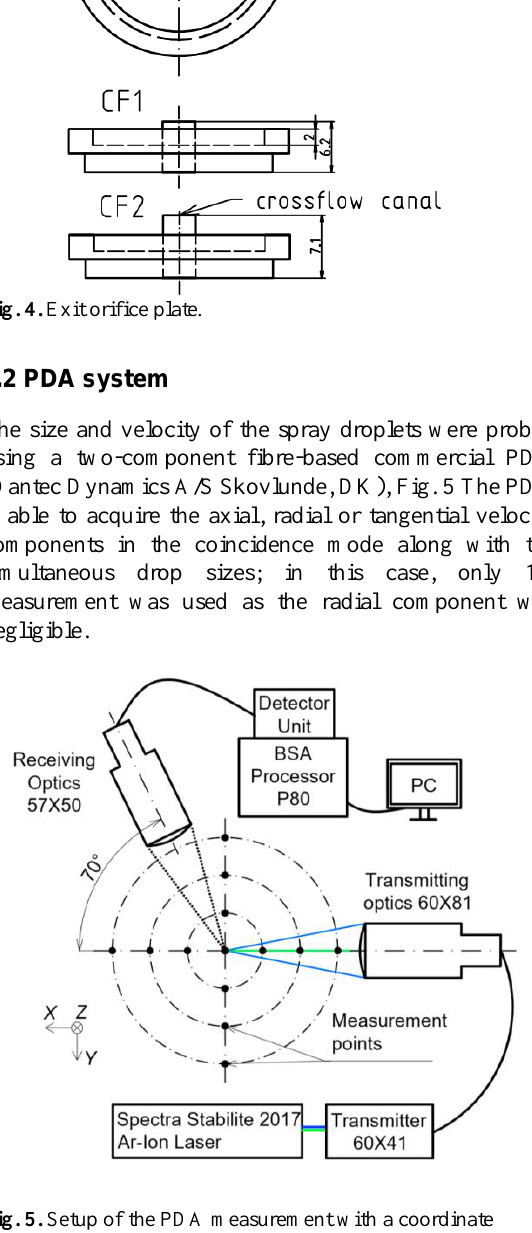
Fig. 5. Setup of the PDA measurement with a coordinate system [4] .